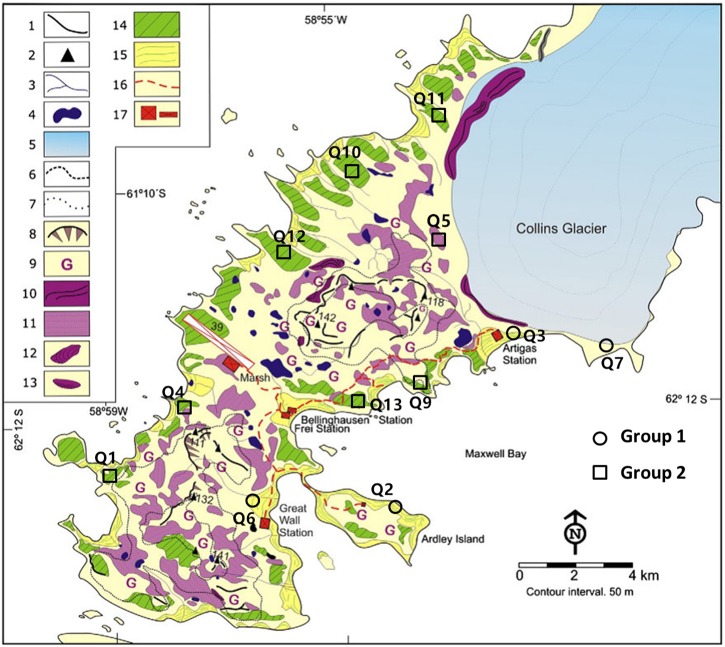
Geomorphological map of the Fildes Region derived from Michel et al. Quadrats of Group 1 and Group 2 were located at Holocene raised beaches (No. 15) and marine platforms (periglacial landforms belonging to Tertiary volcanic stratigraphy, No. 14). The landform type of quadrat Q7 can be deemed as part of the Holocene raised beaches because it suffered recent glacio-isostatic uplift but was still covered by ice during that uplift (personal communication with Michel, 2018). Please refer to original literature for landforms marked by other numbers. Reprinted from Michel et al. (2014), with permission from Elsevier.